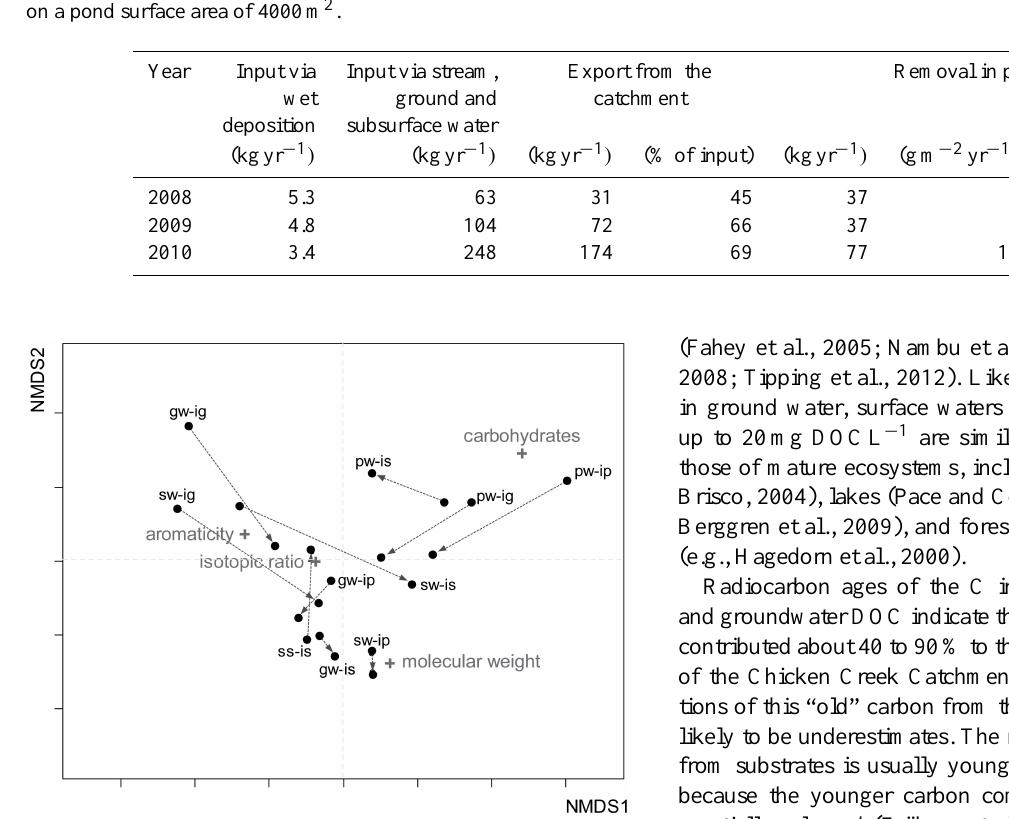
Fig. 7. Two-dimensional ordination plot of nMDS based on Bray– Curtis similarities of mean carbohydrate concentration, SUVA 254 , molecular weight and isotopic ratio of DOC from four water types of the Chicken Creek Catchment incubated with three microbial communities for 7 and 70 days (mean, n = 3). Gray arrows indi- cate major changes in DOC chemical properties and point from day 7 towards day 70; ss – soil solution, gw – upwelling ground water, sw – subsurface water of the alluvial fan, pw – pond water, is – soil microbial community, ig – stream-sediment microbial community, ip – pond-water microbial